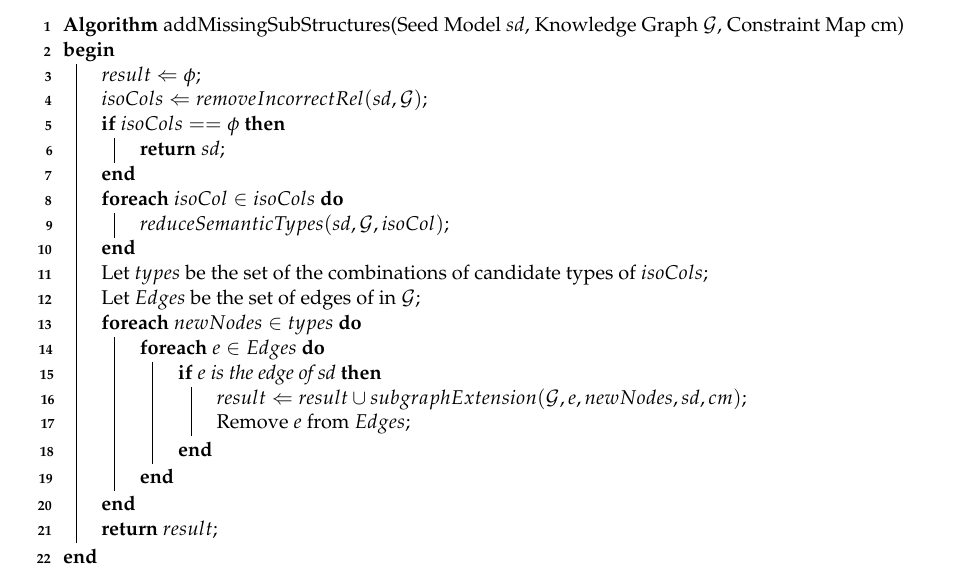
Algorithm 3: Algorithm for repairing the seed model. 1 Algorithm addMissingSubStructures(Seed Model sd , Knowledge Graph G , Constraint Map